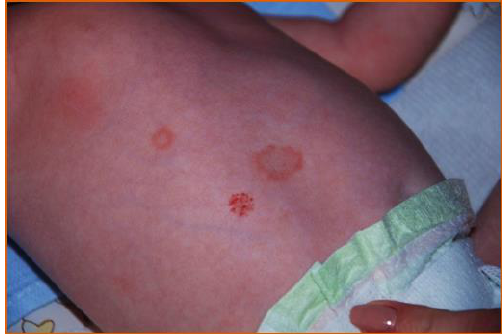
Figure 1. Skin lesion in a one-week-old neonate with